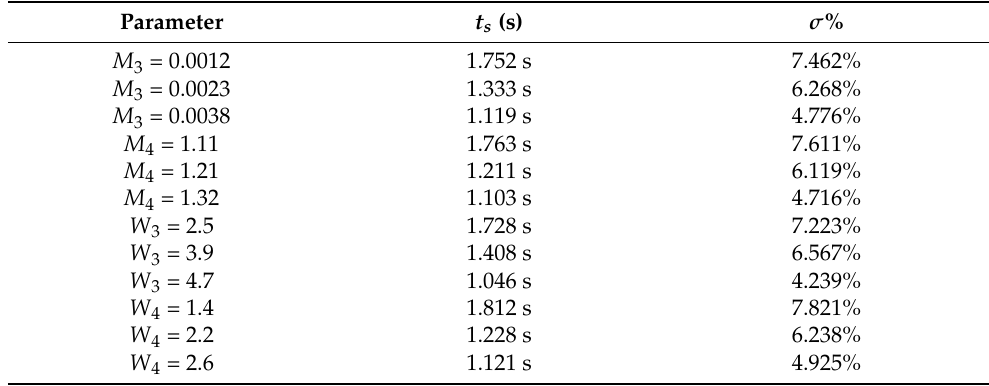
Table 3. t s and σ % of the different values.